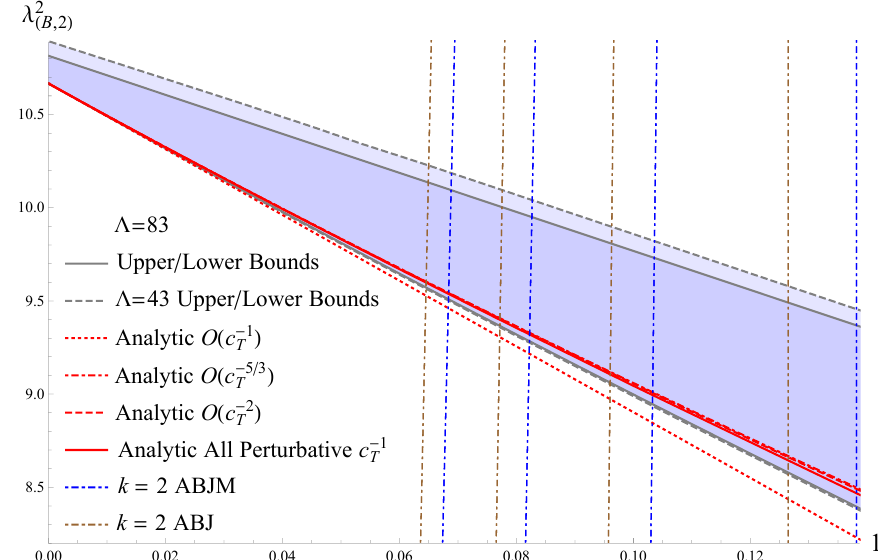
Figure 1 . Upper and lower bounds on the λ 2 OPE coefficient with Λ = 83 (solid gray) and ( B, 2) Λ = 43 (dashed gray) in terms of the stress-tensor coefficient c T in the large c T regime. The red dotted line denotes the large c T expansion to order tree level supergravity O ( c − 1 ) , which is T independent of k , while the red dot-dashed line also includes the tree level R 4 correction at order O ( c − 5 / 3 ) and the red dashed line furthermore includes the 1-loop R | R correction at order O ( c − 2 ) , T T both of which depend on the value k = 2 . The solid red line includes the all orders in 1 /c T expression, which only misses non-perturbative in c T corrections. The blue and brown vertical